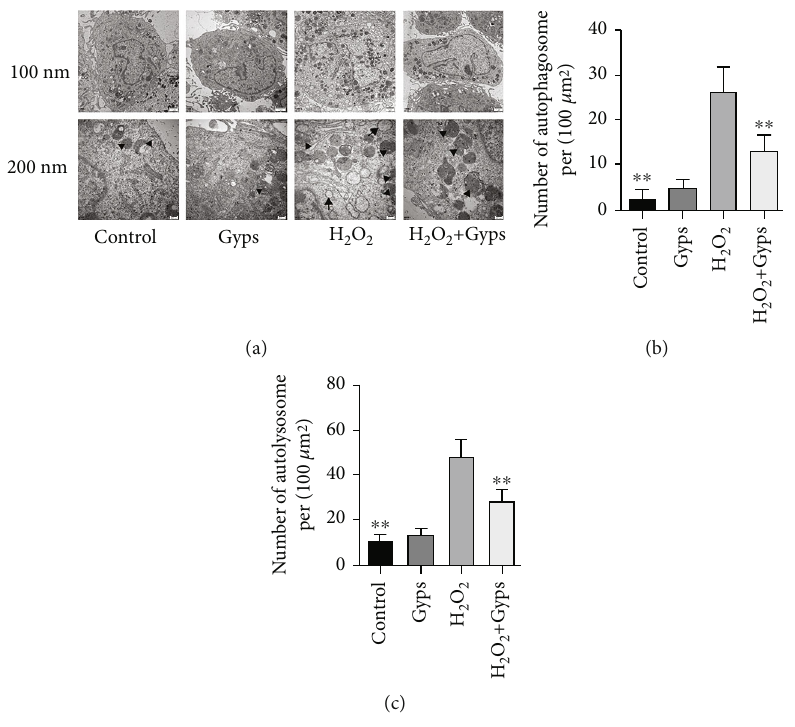
Figure 14: Transmission electron microscopy was used to detect autophagy expression in orbital fi broblasts. (a) Electron micrograph. Arrows indicate autophagosomes, and triangles indicate autophagolysosomes. (b) H autophagosomes, and the number of autophagosomes in the H H O stimulation can increase the number of autophagolysosomes, and the number of autophagolysosomes in the H 2 2 intervention group is lower than that in the H experiment. All detections are repeated 3 times, with 3 replicate wells each time ( ∗ as P < 0 : 05 and ∗∗ as P < 0 : 01 ; P < 0 : 05 means the di ff erence is statistically signi fi cant, and P value is analyzed by one-way